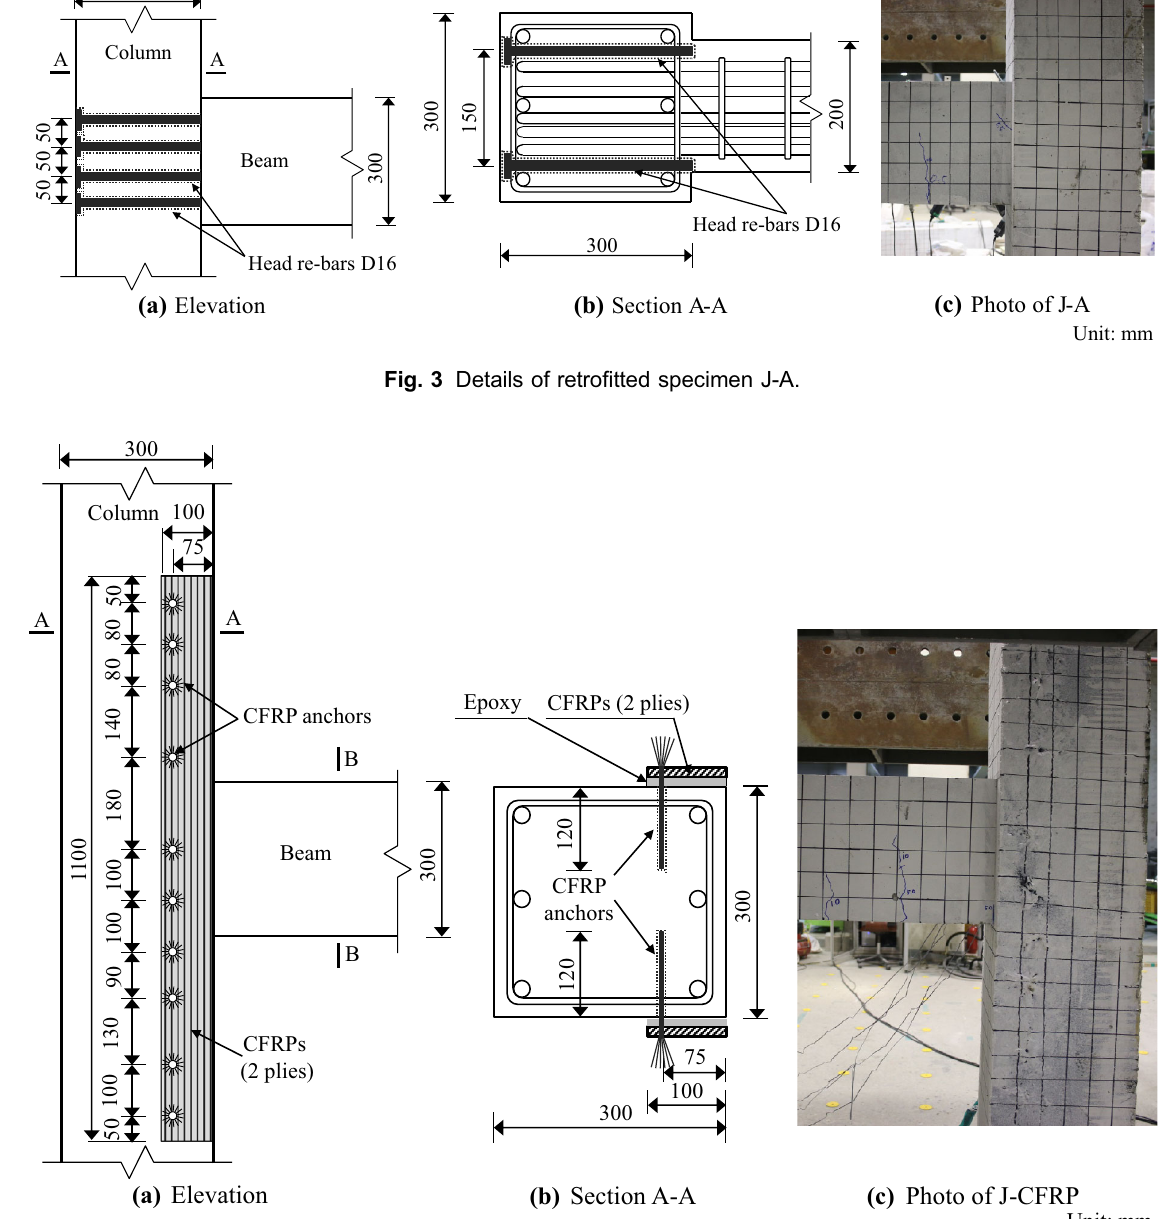
Fig. 4 Details of retrofitted specimen